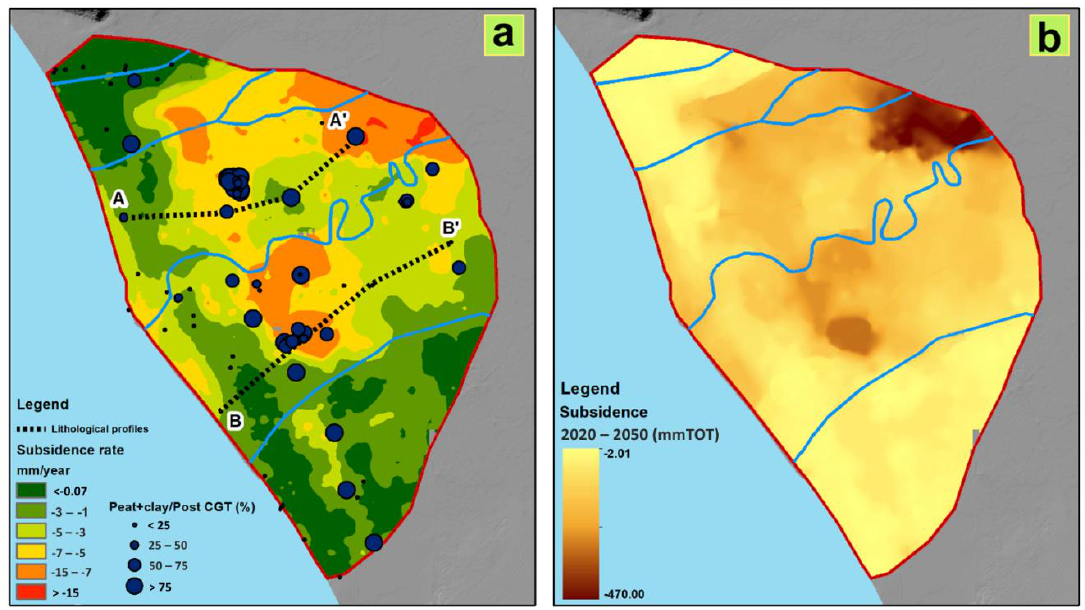
Figure 6. ( a ) Actual subsidence rate (mm/year), classified from lower (green color) to higher (red color) rates, orientation of lithological profiles shown in Figure 7 (dotted lines) and borehole locations (blue dots) classified accordingly to the increasing ratio between Peat + clay/Post-Campania Grey Tuff (CGT). ( b ) Calculated total subsidence (mm) obtained by multiplying the subsidence rate shown in ( a ) for a 30-year period